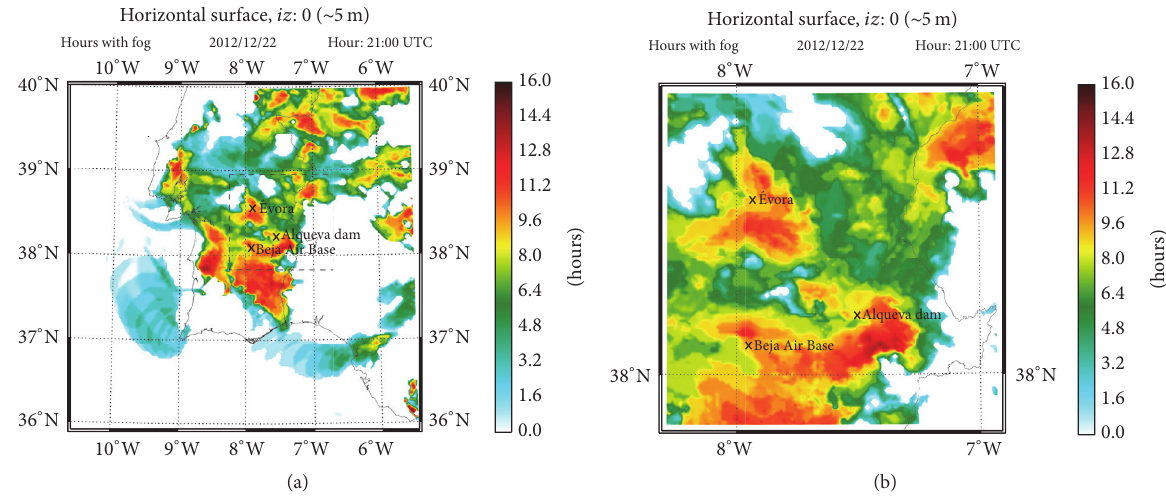
Figure 10: Simulation of the “number of hours with fog” in both domains, between 21:00 and 15:00 UTC.